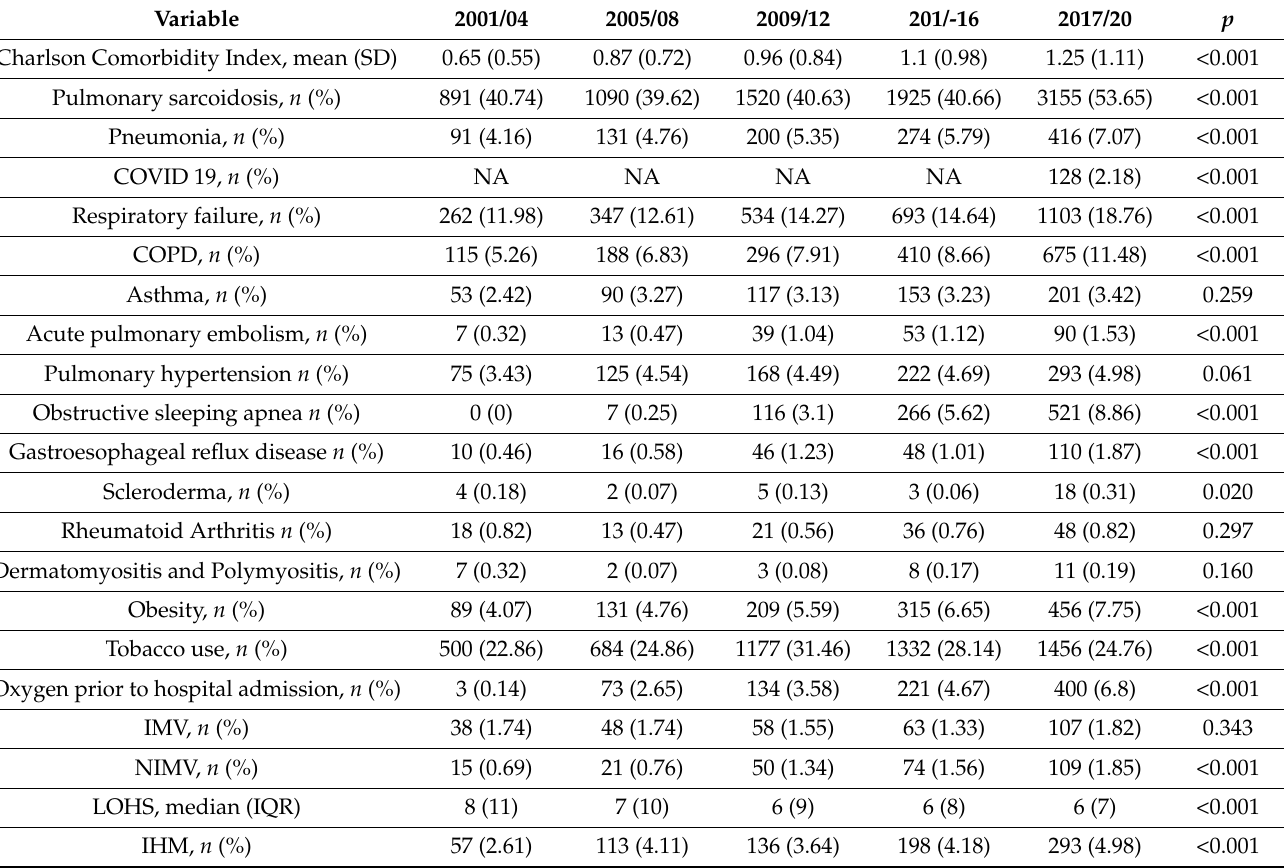
Table 3. Trends in the comorbidities, procedures, and in-hospital outcomes among men hospitalized with sarcoidosis in Spain from 2001 to